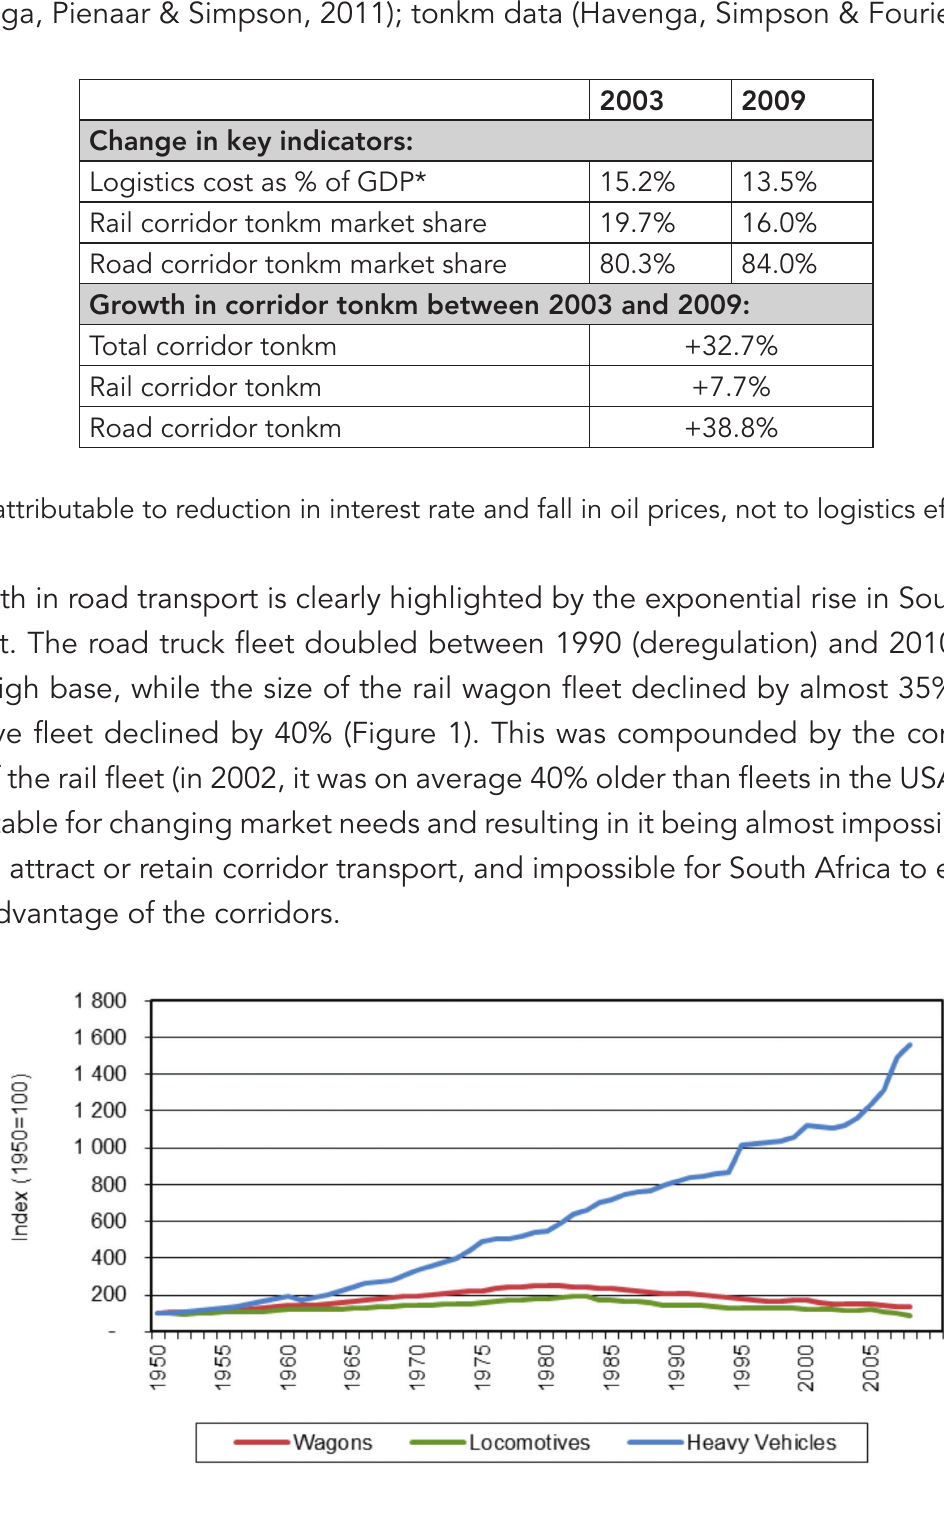
Table 2: Key indicators: South Africa’s national logistics system – logistics cost data (Havenga, Pienaar & Simpson, 2011); tonkm data (Havenga, Simpson & Fourie, 2011)